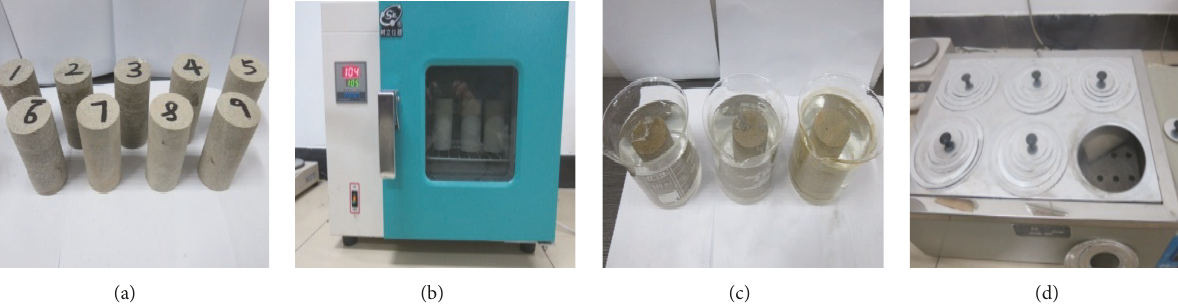
Figure 2: Natural specimens (a), dry specimens (b), natural immersed saturated specimens (c), and boiled saturated specimens (d).